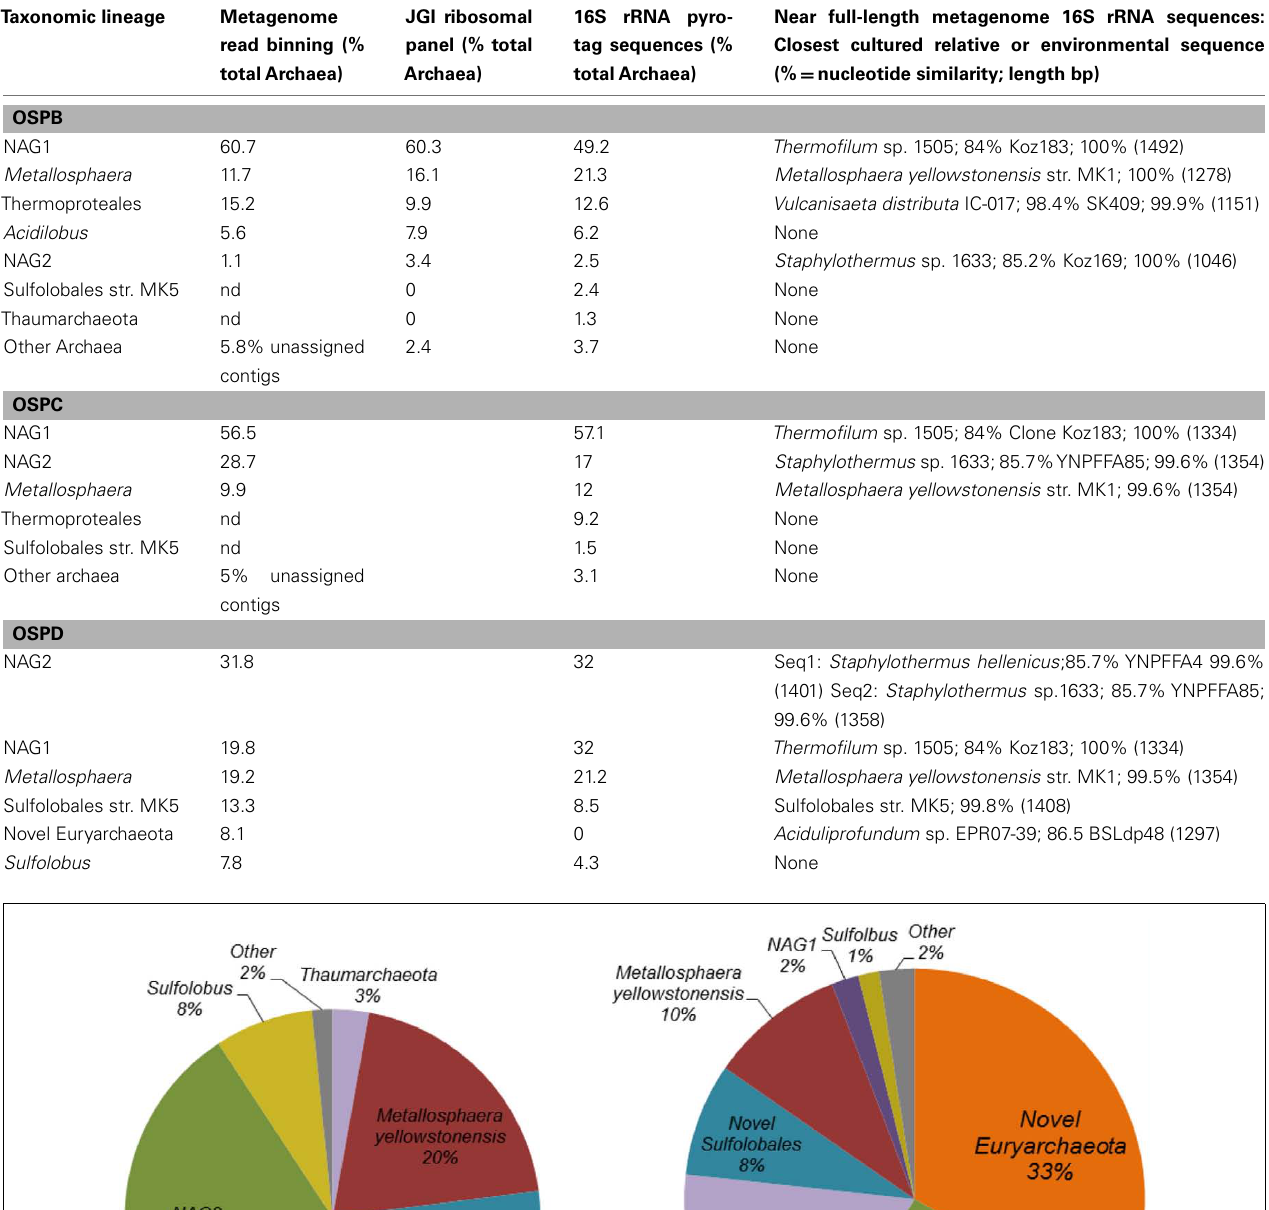
Table 2 | Comparison of methods to determine phylogenetic distribution of archaeal lineages in Norris Geyser Basin OSP Spring.